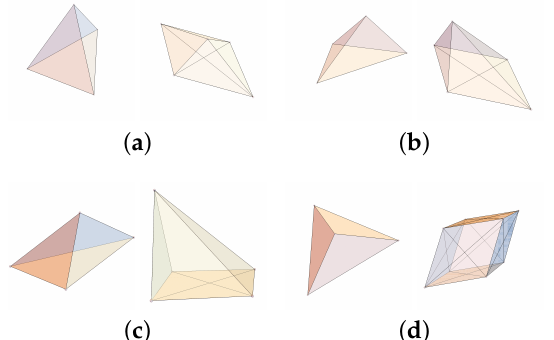
Figure 6. Tiles and corresponding cut-window regions for the tiling T ( D 6 ) . Four tiles are shown (left) alongside their corresponding regions (right) in the cut-window. The tiles T ( D 6 ) are all tetrahedrons while their corresponding regions are pyramids with a rhombic base ( a – c ) or parallelepipeds ( d